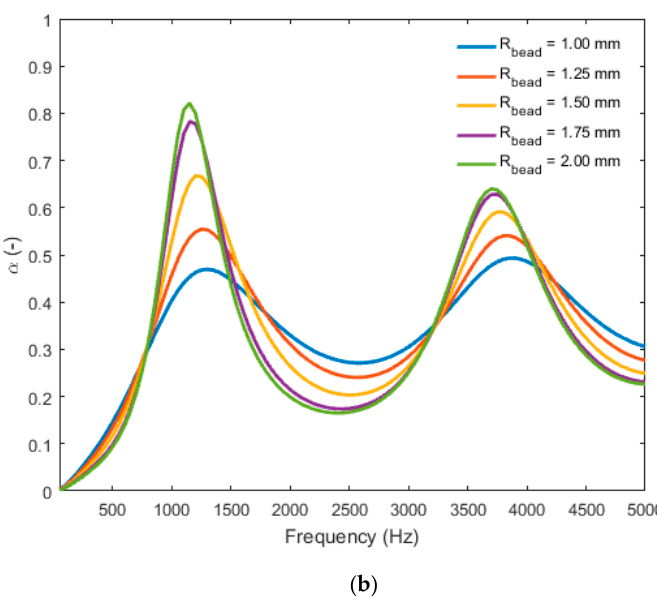
Figure 12. ( a ) Absorption curves at normal incidence with multiple bead sizes and porosity fixed at 16.1% and ( b ) absorption curves at normal incidence with multiple porosities and bead size fixed at 1.7 mm.